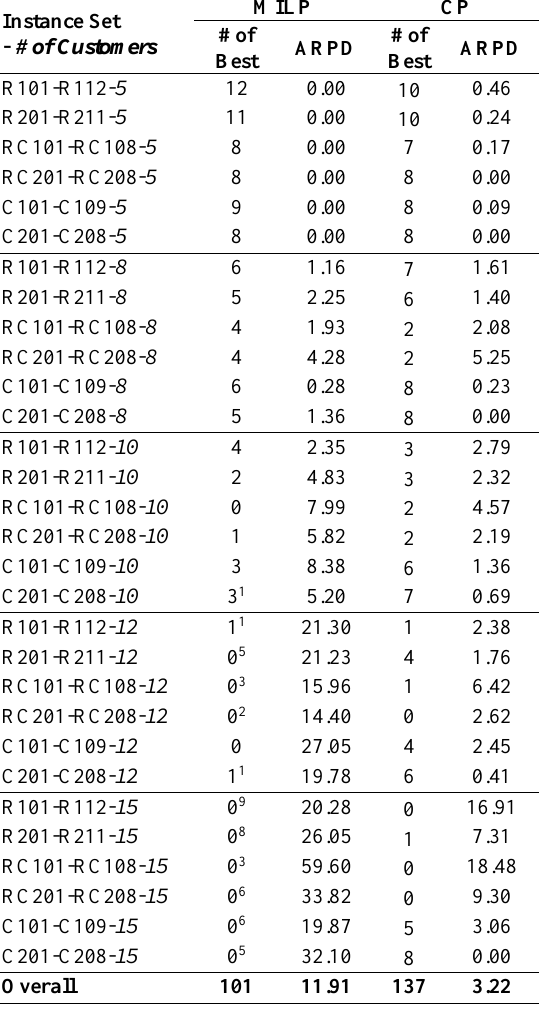
Table 3 indicates that the solution quality of both models gets worse when the time limit decreases to